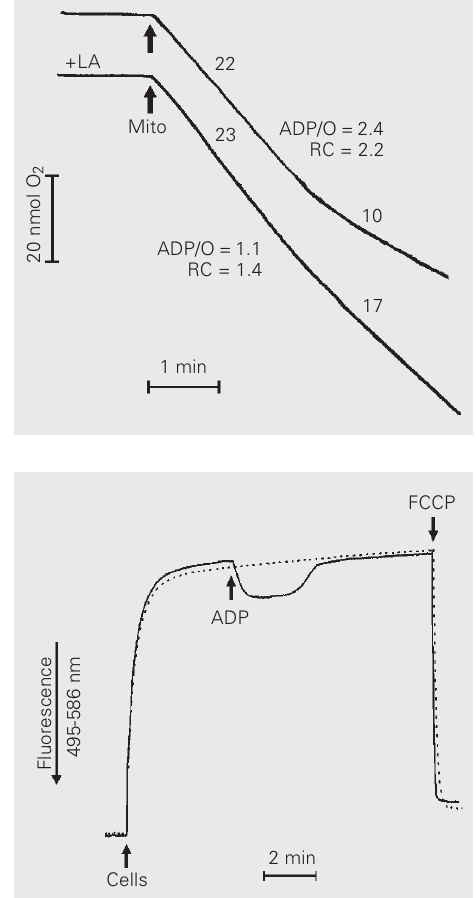
ADPFigure 5. ADP phosphorylation by Candida albicans spheroplast mitochondria. Spheroplasts (1.0 mg/ml) were incubated in reac- tion medium containing 5 mM substrate cocktail (malate, glu- tamate, pyruvate, and α -ketoglu- tarate), 0.05% BSA, and 5 µM safranine O. Spheroplasts (cells), 200 µM ADP, and 1 µM FCCP were added where indicated by the arrows. Dotted line repre- sents a control experiment with- out ADP addition. FCCP = carbo- nyl cyanide p-trifluoromethoxy-